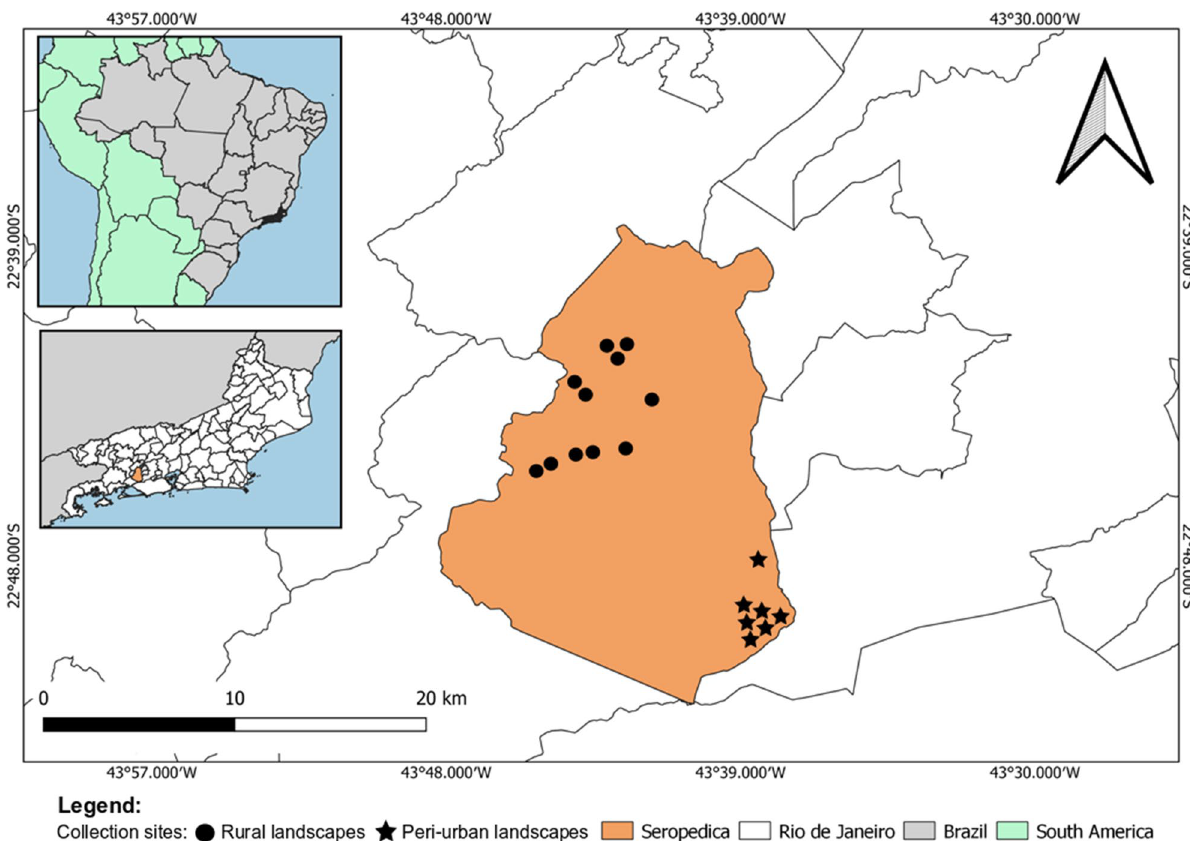
software 3.22.8 ’Białowieża’ (https:// qgis. org/ pt_ BR/